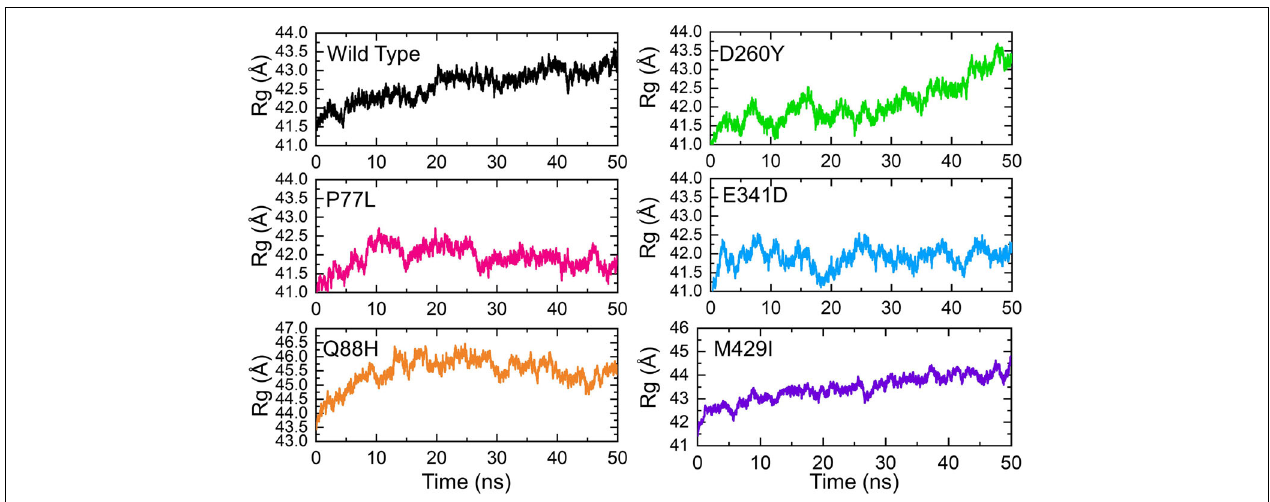
FIGURE 6 | Structural compactness of the NSP13 WT and mutant complexes calculated as radius of gyration (Rg) over the simulation time in nanoseconds. The Rg of WT is represented in black, while different colors are used for the mutants. Rg, radius of gyration.